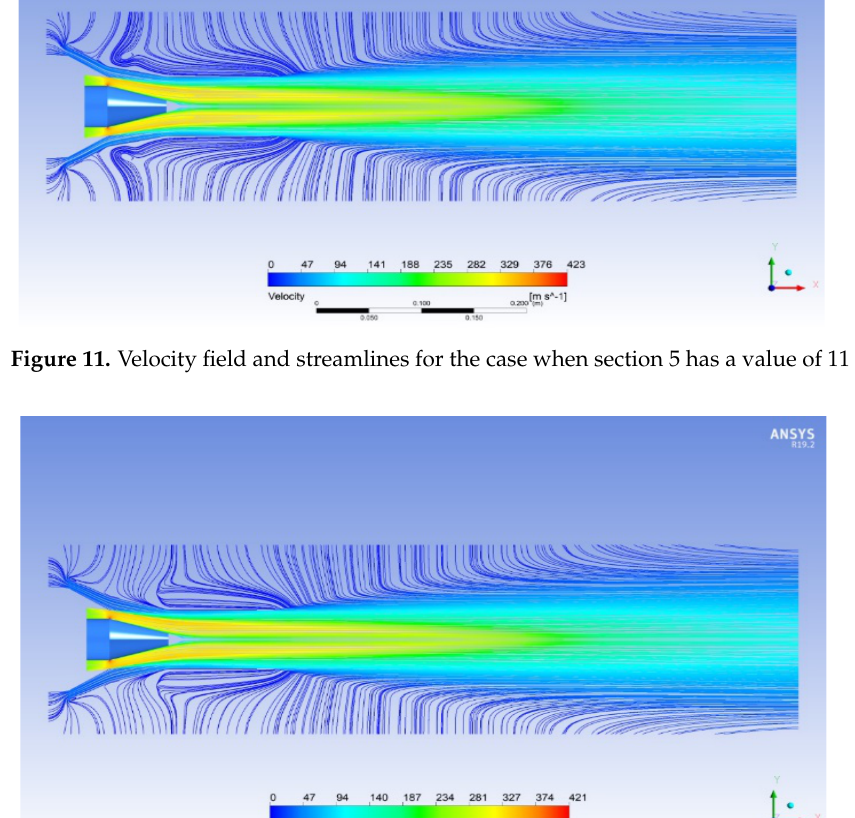
Figure 12. Velocity field and streamlines for the case when section 5 has a value of 12 mm.